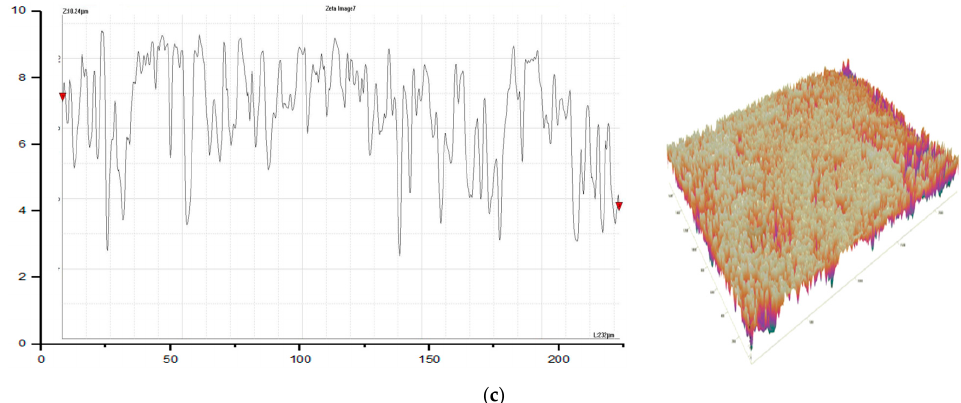
Figure 6. Surface profile and rendered surface profile: ( a ) 50 mm / min: R a ~3.047 µ m; ( b ) 40 mm / min: R a ~6.633 µ m, and ( c ) 30 mm / min.: R a ~9.827 µ m.